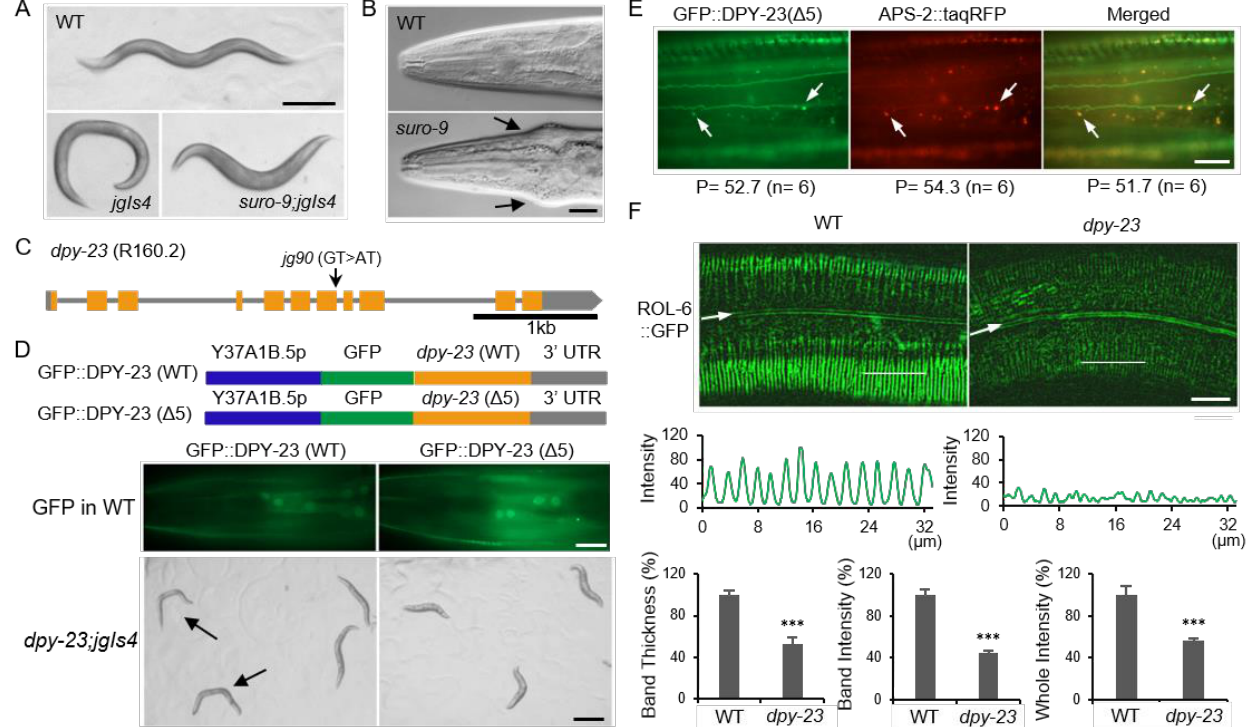
Figure 1. DPY‐23/AP2M1 functions in normal cuticle formation. ( A ) The wild‐type (WT), jgIs4 and suro‐9; jgIs4 strains were observed using a dissecting microscope. The suppressor‐of‐rolling‐9 ( suro‐9 ) is one mutant among cuticle mutants that suppresses the rolling (Rol) phenotype of the jgIs4 strain expressing the mutant ROL‐6 collagen. Scale bars = 200 μm. ( B ) The head region of the suro‐9 mutant was compared to the wild type using a differential interference contrast (DIC) microscope. Arrows indicate the Jowls phenotype. Scale bar = 20 µm. ( C ) The genomic structure of the dpy‐23 gene. The arrow indicates the suro‐9 (jg90) mutation. ( D ) Rescue experiments were performed with two different constructs expressing the wild‐type DPY‐23 (GFP::DPY‐23 (WT)) or the mutant DPY‐23 (GFP::DPY‐23 (Δ5)) by the Y37A1B.5 promoter (Y37A1B.5 p ) (upper panel). Y37A1B.5 is expressed in the hypodermis and DPY‐23 (Δ5) indicates the 5‐amino acids‐deletion form of DPY‐23 derived from suro‐9 (jg90). The transgenic nematode expressing either GFP::DPY‐23 (WT) (left panel) or GFP::DPY‐23 (Δ5) (right panel) in the wild‐type background was observed using a fluorescence microscope (middle panel). The dpy‐23; jgIs4 strain expressing either GFP::DPY‐23 (WT) (left panel) or GFP::DPY‐23 (Δ5) (right panel) was observed using a dissecting microscope (bottom panel) . Arrows indicate rolling animals. Scale bars = 20 μm (middle panel) and 500 μm (bottom panel). ( E ) The transgenic nematode expressing GFP::DPY‐23 (Δ5) and APS‐2::tagRFP simultaneously in the hypodermis was observed to examine the complex formation of the mutant DPY‐23 protein with other subunits of the clathrin‐associated complex II (AP‐2). Arrows indicate AP‐2 punctae. P = average number of punctae (n = worm number observed). P of the merged image indicates the number of overlapping punctae. Scale bar = 20 μm. ( F ) The expression of ROL‐6::GFP in the dpy‐23 mutant was compared to the wild type. The fluorescence intensity was measured along the thin white line in the upper panel and was presented graphically in the middle panel. The relative band thickness, relative band intensity, and relative whole intensity of ROL‐6::GFP in the wild type and the dpy‐23 mutant were quantified (bottom panel). Arrows indicate alae. Scale bar = 20 μm. Error bar = SEM. *** p < 0.001 versus WT.